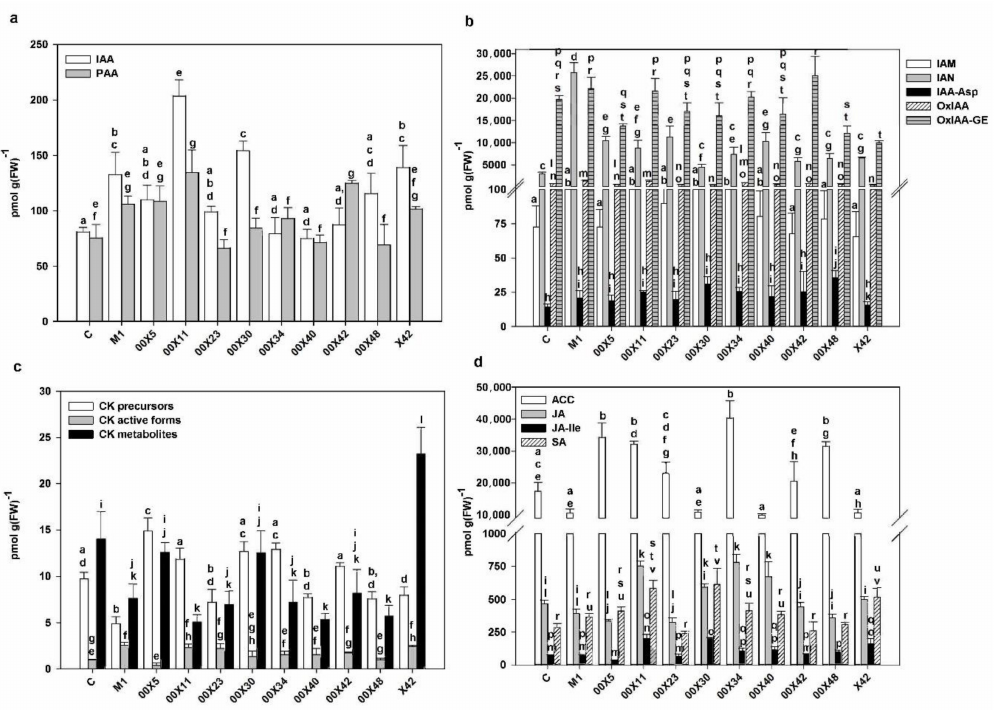
Figure 8. Phytohormone contents in the rapeseed leaves. Active auxins ( a ), precursors and deactivation products of auxins ( b ), cytokinins ( c ), aminocyclopropane-carboxylic acid, jasmonic acid; jasmonate-isoleucine, salicylic acid ( d ). Each code (00X5, 00X11, 00X23, 00X30, 00X34,